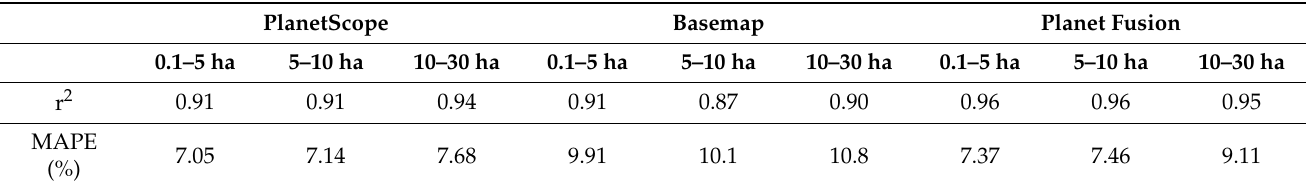
Figure 3. Pairwise comparisons between the SkySat validation surface area and the surface area obtained from PlanetScope, Basemap, and Planet Fusion for multiple observations in time. Table 4. Pairwise comparisons between the SkySat validation surface area and the surface area obtained from PlanetScope, Basemap, and Planet Fusion for multiple observations in time and divided into three size classes.